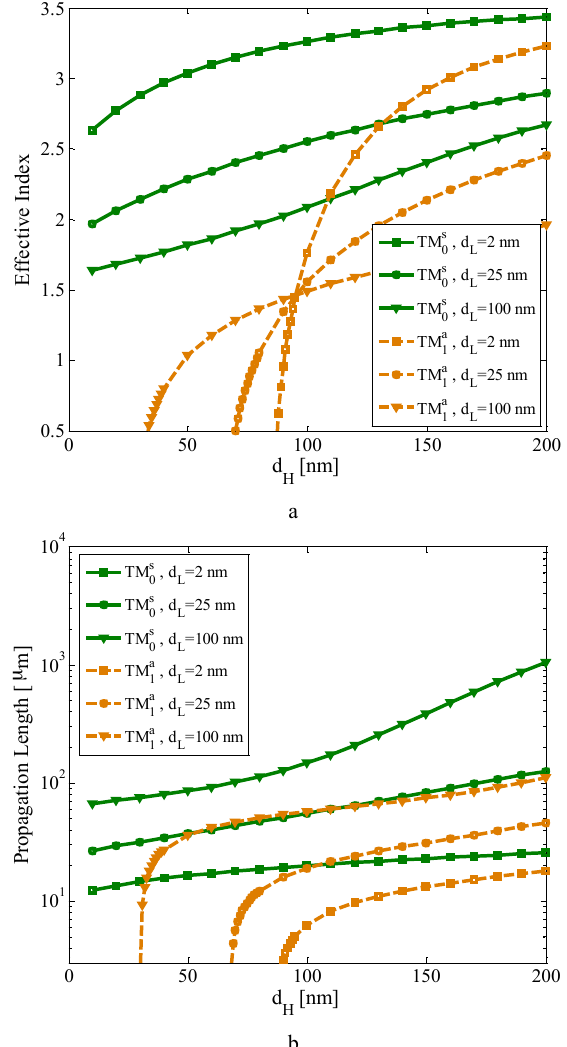
Figure 4: a. Effective refractive index and b. Propagation length, of the first two TM polarized hybrid-guided modes of the HMIM slab waveguide in terms of d H and d L . Thickness of the S-Layer is chosen to be d S =20 nm. Indexes “s” and “a” stand for symmetric and anti-symmetric modes, respectively.